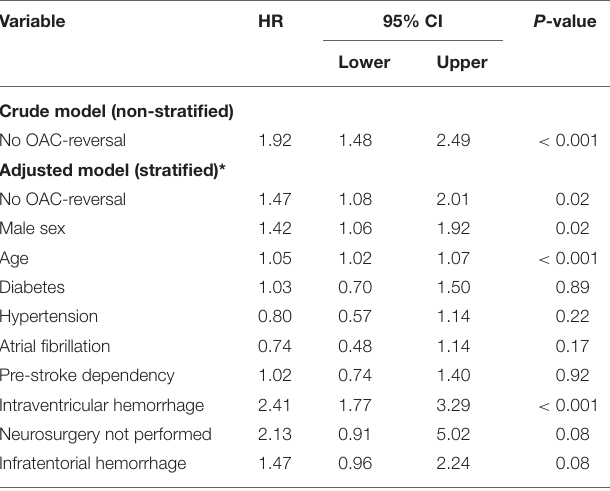
TABLE 2 | Cox regression analysis stratified for level of consciousness showing Hazard Ratios (HR) for 90-day mortality in 572 patients with OAC-ICH.